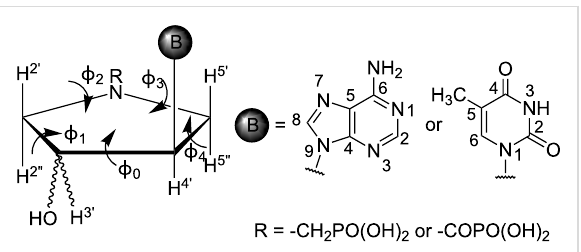
Figure 3: The numbering of the pyrrolidine ring, the nucleobase and the endocyclic phase angles for the purposes of the conformational analysis.